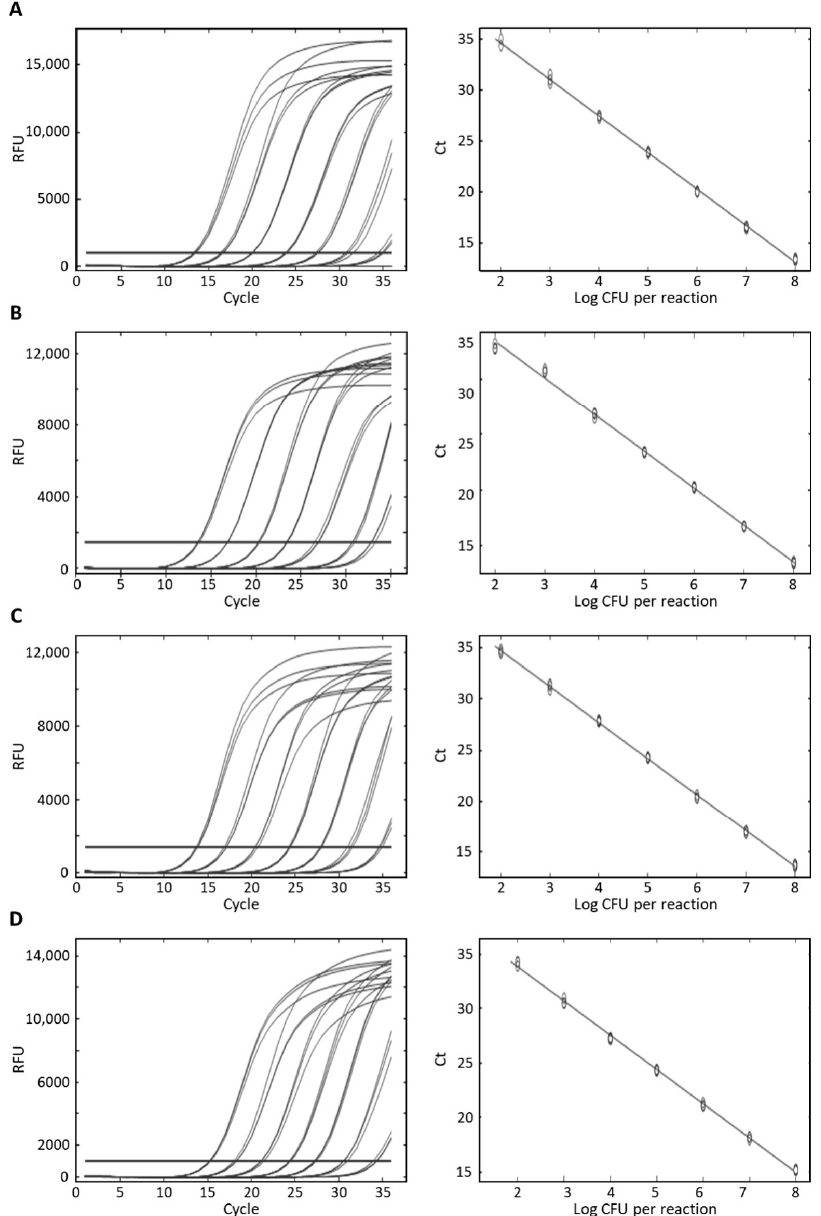
Figure 3. Standard curves by plotting cycle threshold (Ct) values against the logarithm of the number of cells of ( A ) S. aureus , ( B ) S. capitis , ( C ) S. caprae , and ( D ) S. epidermidis in pure culture.